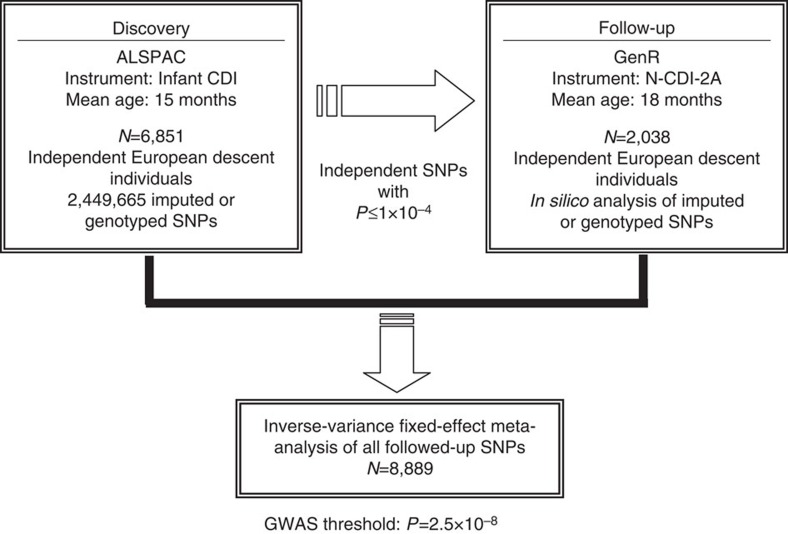
Study design for the genome-wide screen of early expressive vocabulary.Expressive vocabulary between 15 and 18 months of age was assessed using different forms of the MacArthur Communicative Development Inventories (CDI). Detailed phenotype descriptions are given in Supplementary Data 1.